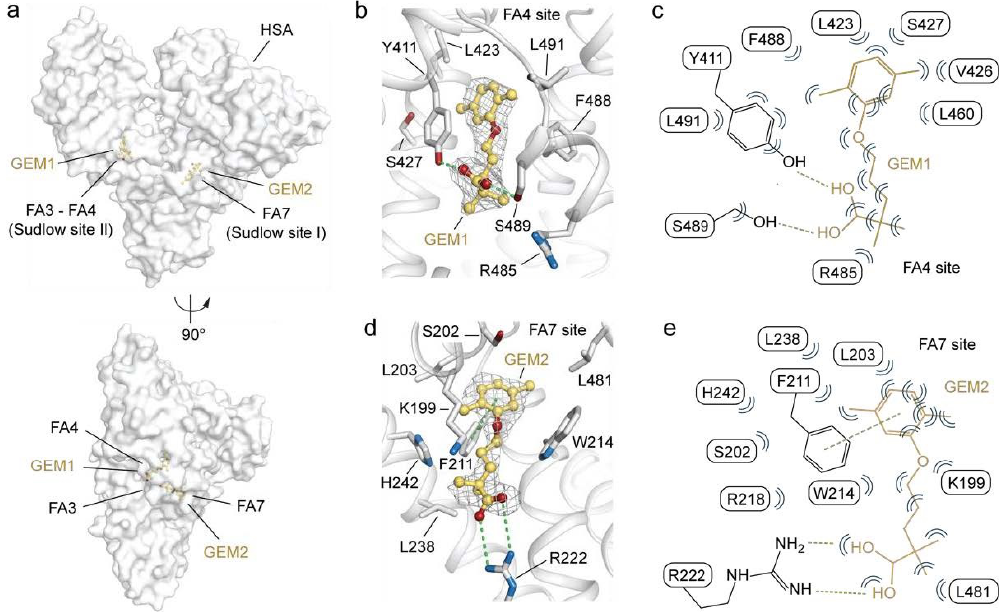
Figure 2. Details on the binding mode of GEM ligands to HSA. ( a ) Molecular surface representation of the overall HSA-GEM complex (white) shown in two orientations (90° rotation); ( b ) detailed view of GEM1 bound to FA4 in sub-domain IIIA; ( c ) schematic representation of molecular interactions between HSA residues and GEM1; ( d ) detailed view of GEM2 bound to FA7 in sub-domain IIA; ( e ) schematic representation of molecular interactions between HSA residues and GEM2. The α -helices of HSA are depicted as cartoon loops (white), and the selected labelled amino acid side chains are represented as sticks and coloured by atom type (carbon = white, oxygen = firebrick, and nitrogen = sky blue). Bound GEM molecules are depicted as ball-and-stick models coloured by atom type (carbon = yellow orange and oxygen = firebrick). The composite omit maps representing the ( F o − F c ) electron density of GEM ligan ds are contoured at 2.5σ and shown as a grey mesh. Hydrogen bonds, salt bridges, and π–π intermolecular interactions are shown as green dashed lines. Bent blue lines indicate residues of HSA in close contact with GEM ligands (distances shorter than 4.0 Å that are not hydrogen bonds). The three-dimensional structure models were generated and rendered using Pymol [29].